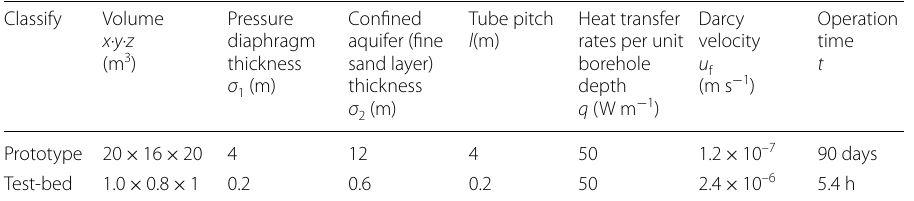
Table 3 Engineering prototype and experimental system design parameters